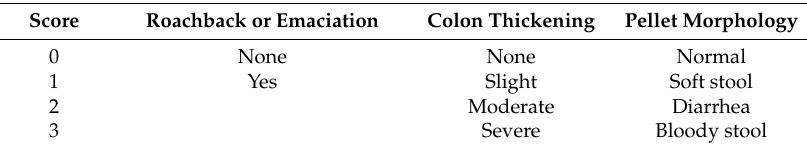
Table 1. The scoring system of clinical score.